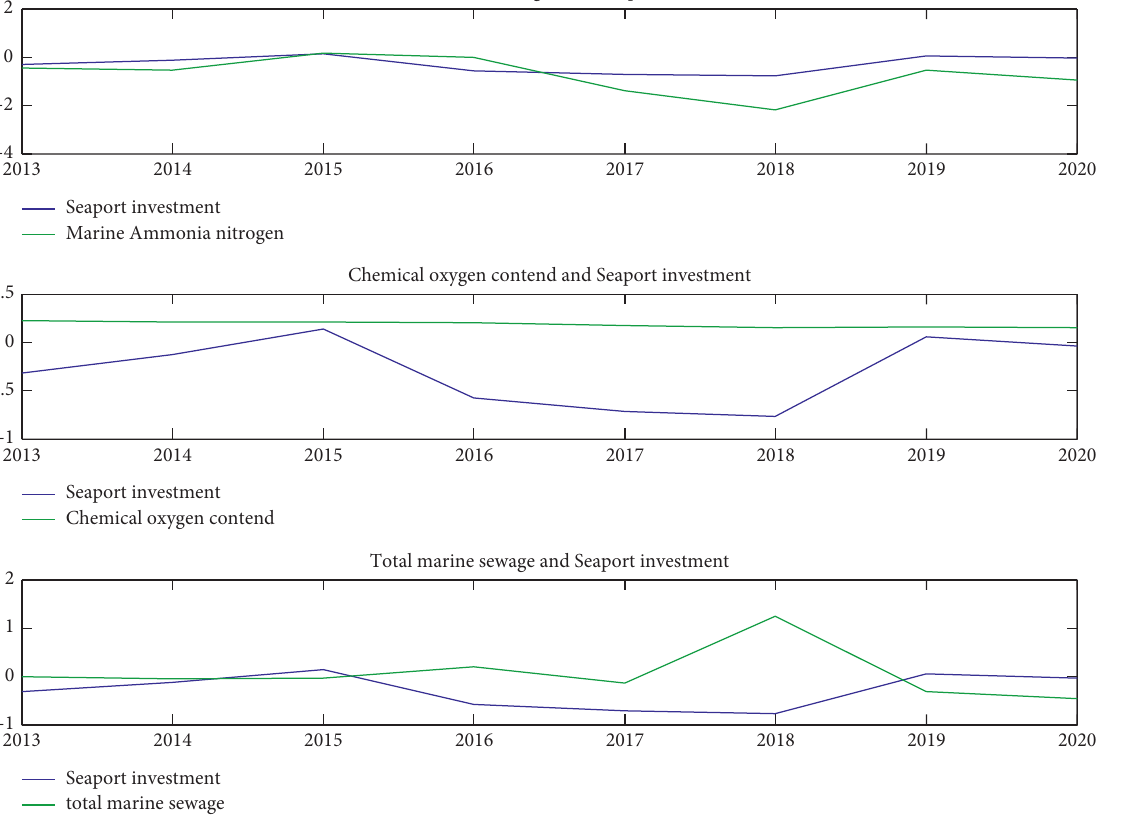
Figure 3: Seaport investment and total sewage, chemical oxygen content, and ammonia nitrogen. Table 2: Partial bayes